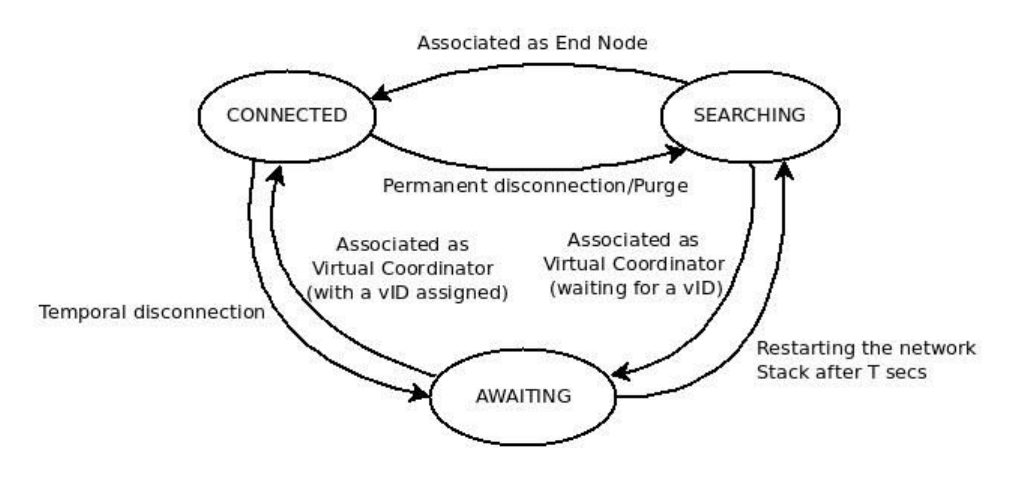
Figure 2. DARAL state machine.